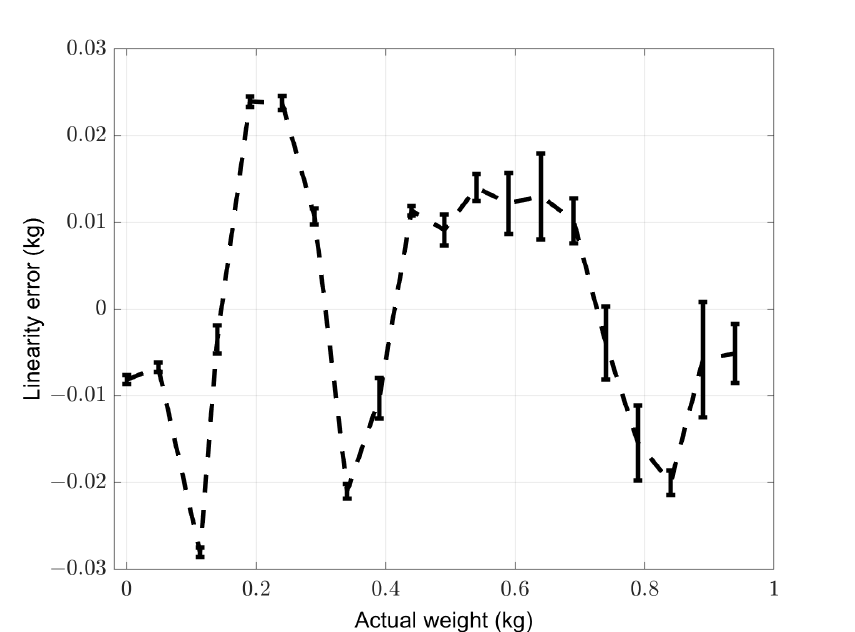
Figure 10. The linearity error of the sensor analog front-end. Error bars represent the uncertainty on linearity error.